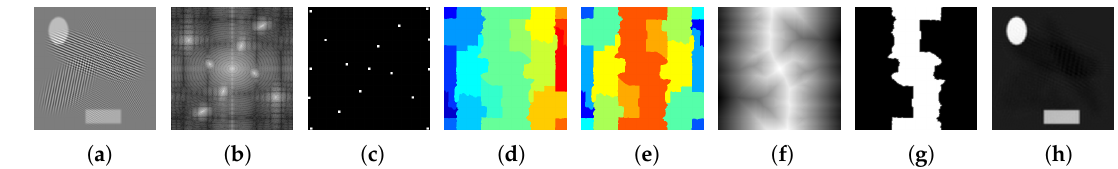
Figure 5. Step by step construction of empirical watershed wavelets: ( a ) Original image, ( b ) Magnitude spectrum of image, ( c ) Detected persistent maxima using method from Section 3.2.1, ( d ) detected partitioning of the spectrum using method from Section 3.2.2, ( e ) Paired regions if image is real, ( f ) Distance transform of central region, ( g ) Empirical watershed wavelet of central region, ( h ) Empirical watershed wavelet coefficient for the central region.